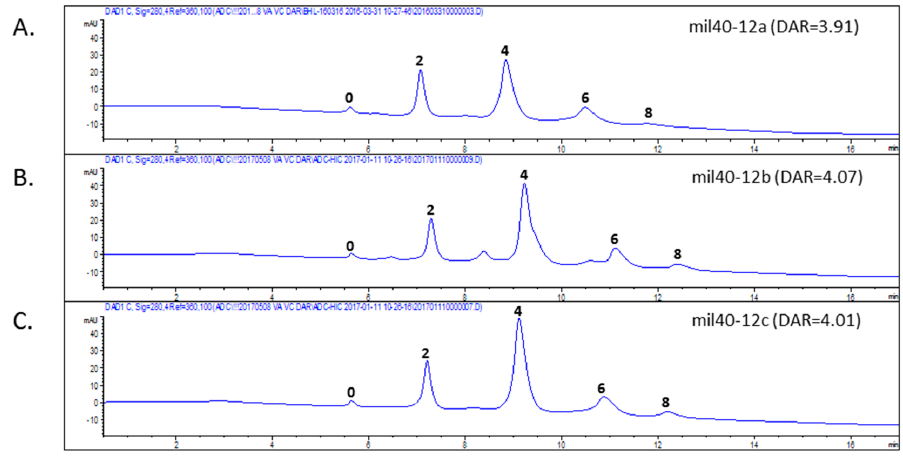
Figure 3. HIC analysis of ADCs. HIC allowed resolution of the conjugates into several major peaks corresponding to 0, 2, 4, 6, and 8 drug molecules per antibody. ( A ) Drug distribution of ADC mil40- 12a , DAR = 3.91; ( B ) Drug distribution of ADC mil40- 12b , DAR = 4.07; ( C ) Drug distribution of ADC mil40- 12c , DAR = 4.01. DAR: drug to antibody ratio.